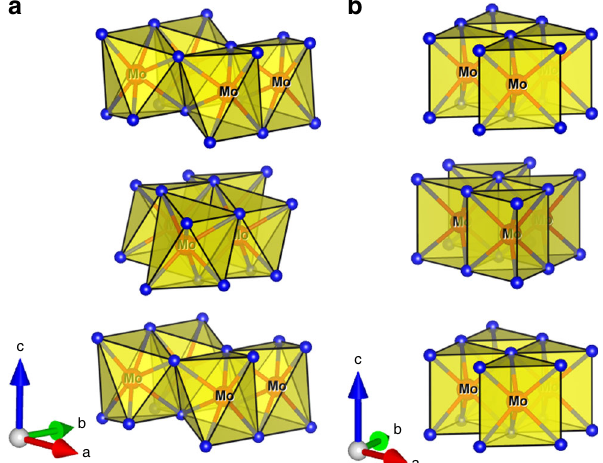
Fig. 1 Crystal structure and {MoTe} 6 polyhedra showing the building blocks of each polymorph. a monoclinic 1T ′ -MoTe 2 phase and b hexagonal 2H- MoTe 2